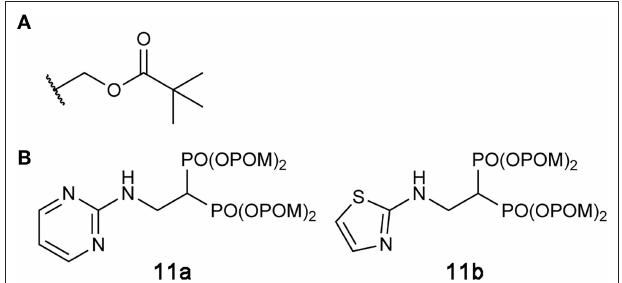
FIGURE 10 | Prodrugs to target hFPPS. (A) The structure of the pivaloyloxymethyl (POM) group. (B) Examples of POM-protected N-BP prodrugs.